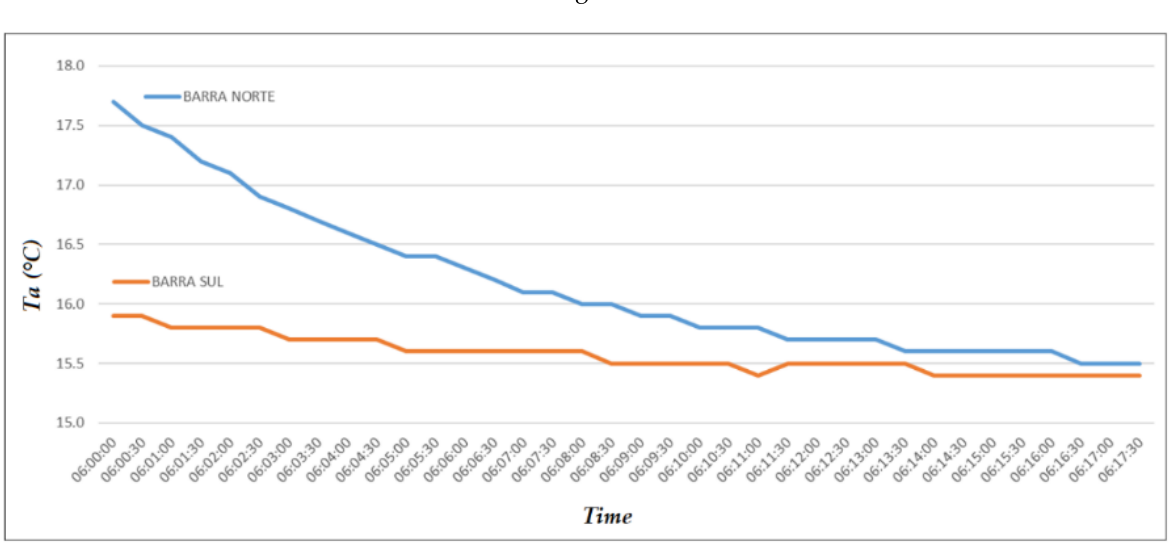
Figure 9. Chart of the Ta variability in the fixed points.